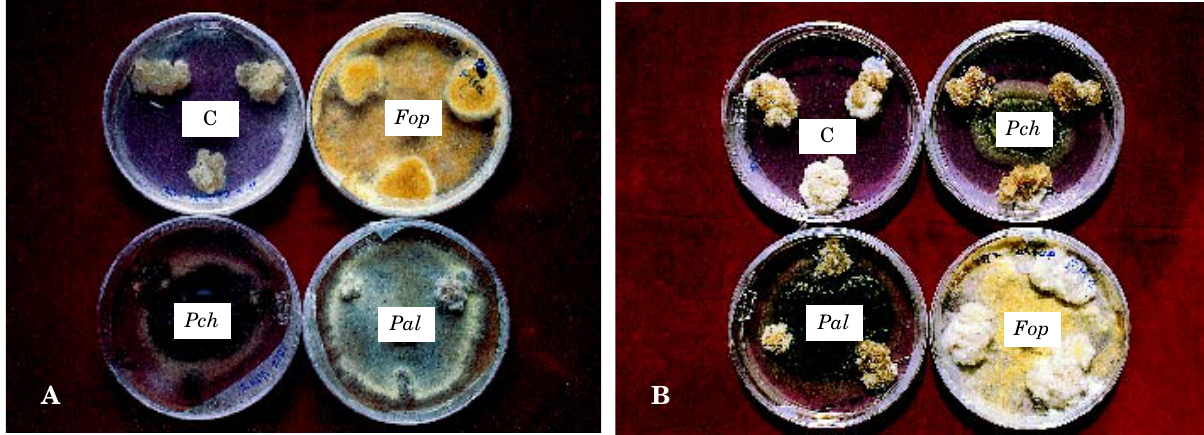
Fig. 3. Callus cultures of grapevine cv. Italia (A) or tobacco cv. White Burley (B) grown in the presence of P. chalmy- dosporum ( Pch ), P. aleophilum ( Pal ) and F. punctata ( Fop ). C = controls.